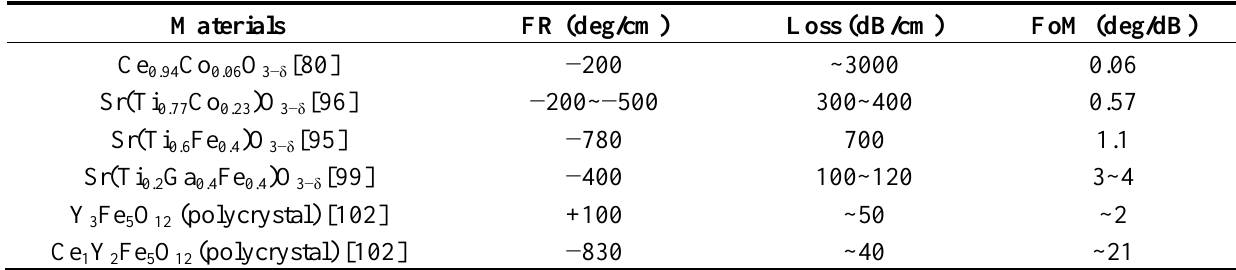
Table 2. Magneto-optical thin film candidates for on-chip nonreciprocal photonic devices at 1550 nm discussed in this paper.